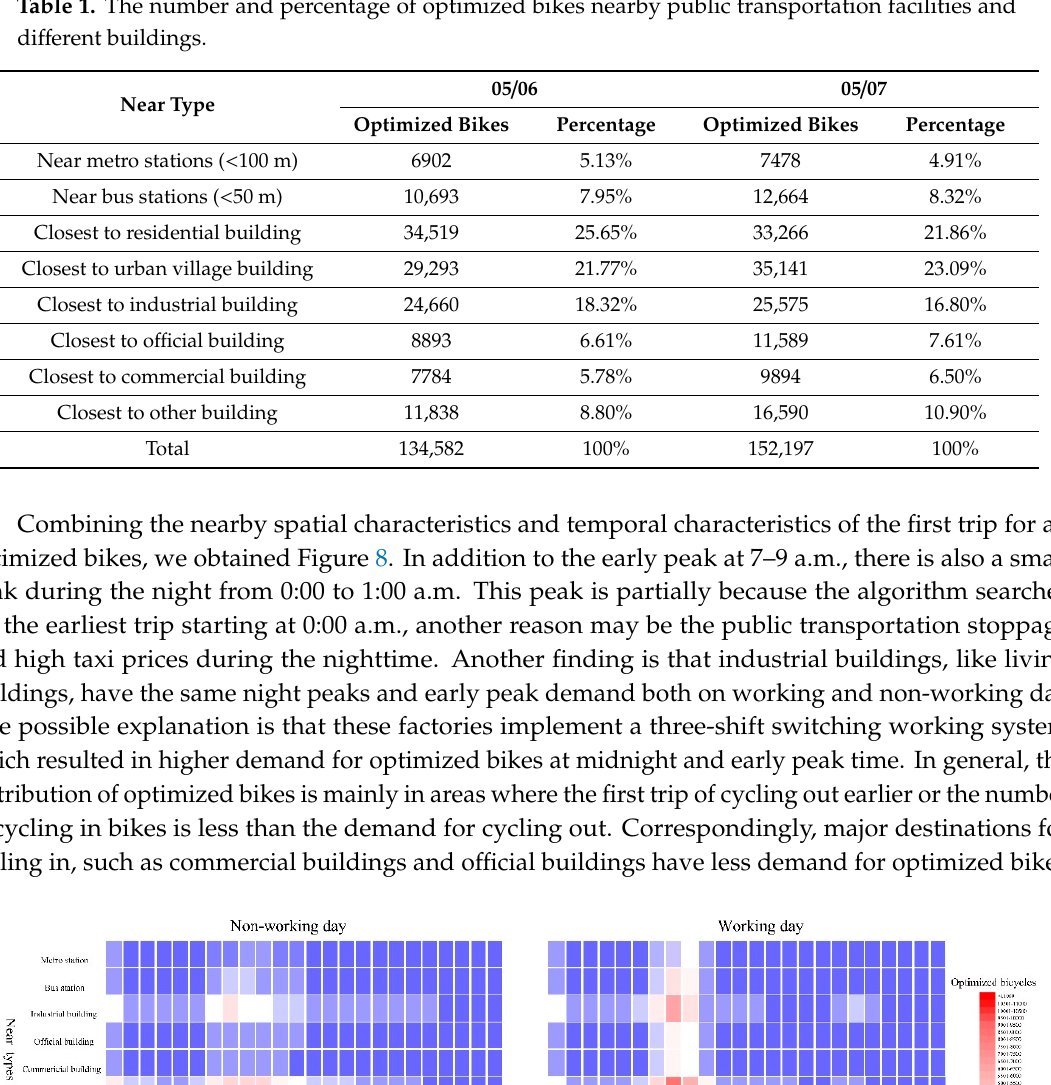
Table 1. The number and percentage of optimized bikes nearby public transportation facilities and di ff erent buildings.